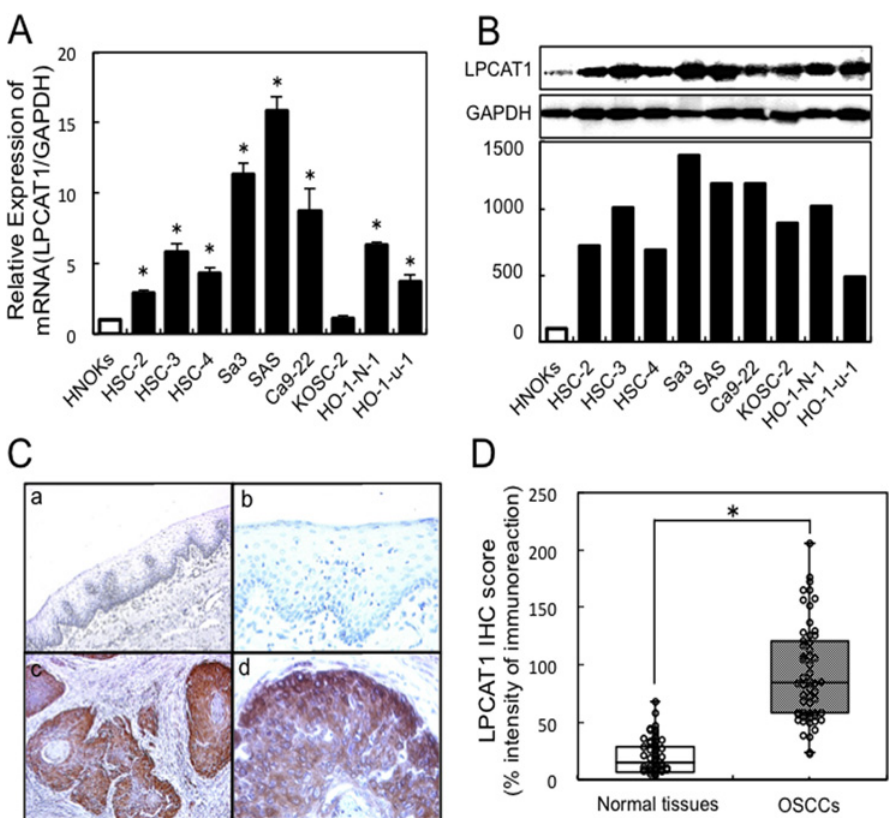
Fig 1. Expression profiles of LPCAT1 in OSCC-derived cell lines and OSCC samples. ( A ) Quantification of LPCAT1 mRNA levels in OSCC-derived cell lines by qRT-PCR analysis. To determine the mRNA expression status of LPCAT1 , we performed qRT-PCR analysis using 9 OSCC-derived cell lines (HSC-2, HSC-3, HSC-4, Sa3, SAS, Ca9 – 22, KOSC2, HO-1-N-1, and HO-1-u-1), and HNOKs. LPCAT1 mRNA is significantly up-regulated in the nine OSCC-derived cell lines compared with the HNOKs. The data are expressed as the mean ± SEM of values from three assays ( * p < 0.05, Mann-Whitney U test). ( B ) Immunoblot analysis of LPCAT1 in the OSCC-derived cells lines and HNOKs. To investigate the protein expression status of LPCAT1, we performed immunoblot analysis in the same OSCC-derived cell lines and HNOKs. The LPCAT1 protein expression level is significantly up-regulated in all OSCC-derived cell lines compared with the HNOKs. Densitometric LPCAT1 protein data are normalized to the GAPDH protein levels. The values are expressed as a percentage of the HNOKs. ( C ) IHC of LPCAT1 on primary OSCC samples. Representative IHC results are shown for LPCAT1 protein in normal oral tissue (a, b) and primary OSCCs (c, d). The original magnifications are 100×(a, c), and 400×(b, d). Strong LPCAT1 immunoreactivity is detected in the primary OSCCs. ( D ) The status of LPCAT1 protein expression in primary OSCCs (n = 55) and the normal counterparts. The LPCAT1 IHC scores are calculated as follows: IHC score = 1×(number of weakly stained cells in the field) + 2×(number of moderately stained cells in the field) + 3×(number of intensely stained cells in the fields). The LPCAT1 IHC scores for normal oral tissues range from 0.5 to 68.5 and that of primary OSCCs range from 23.7 to 205.9. The LPCAT1 protein expression levels in OSCCs are significantly ( * p < 0.01, Mann- Whitney U test) higher than those in normal oral